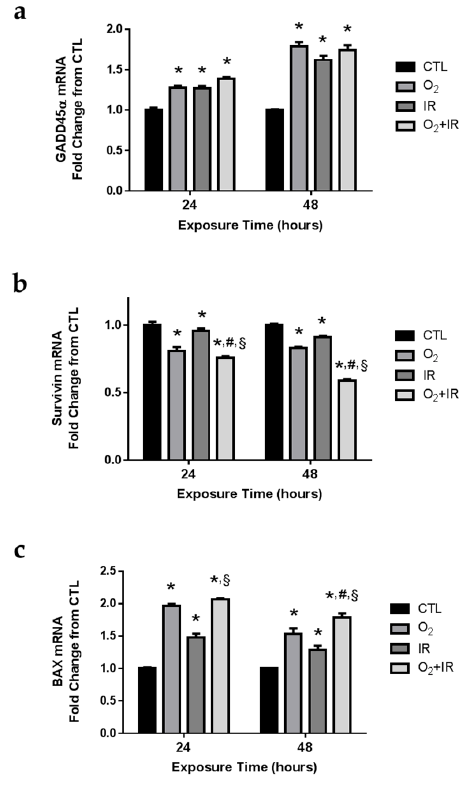
Figure 7. Determination of apoptosis-associated gene expression changes in lung epithelial cells exposed to hyperoxia, radiation, and double-hit combination challenge. Non-tumorigenic murine alveolar type II epithelial cells (C10) were evaluated after 1 and 2 cycles of hyperoxia and radiation exposure and evaluated by quantitative real-time PCR analysis for ( a ) GADD45 α ; ( b ) Survivin ; and ( c ) BAX gene expression. Levels of target gene mRNA were normalized to 18S ribosomal RNA and values are expressed as the mean fold change from CTL. Data are presented as mean ± SEM. * p < 0.05 for each exposure condition as it compares with the unexposed control (CTL) in the same respective time-group; # p < 0.05 for significant differences between O 2 -alone compared to O 2 + IR; § p < 0.05 for significant differences between IR-alone compared to O 2 + IR.